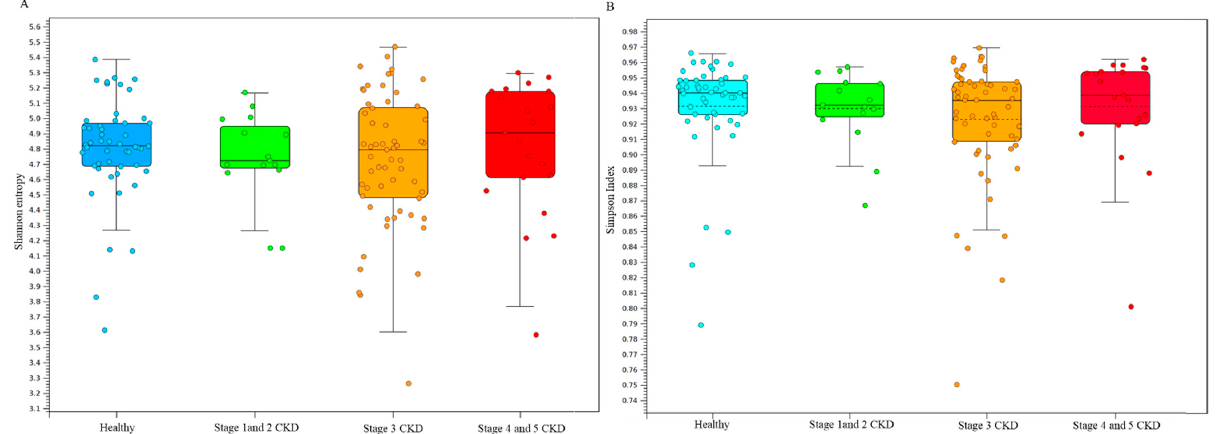
Figure 2. Diversity of taxonomic alignments between groups evaluated with long-read sequencing results. The alpha- diversity in all groups from the MinION results is illustrated using ( A ) Shannon entropy and ( B ) the Simpson index.